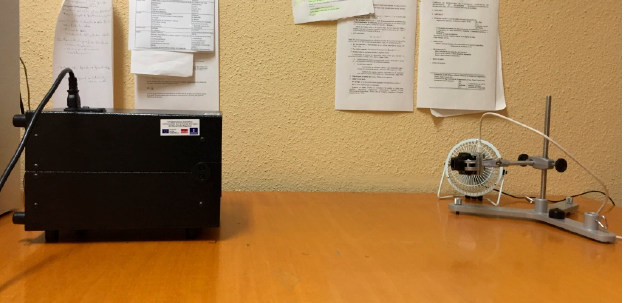
Figure 2. Disposal of the blackbody and the camera for calibration.